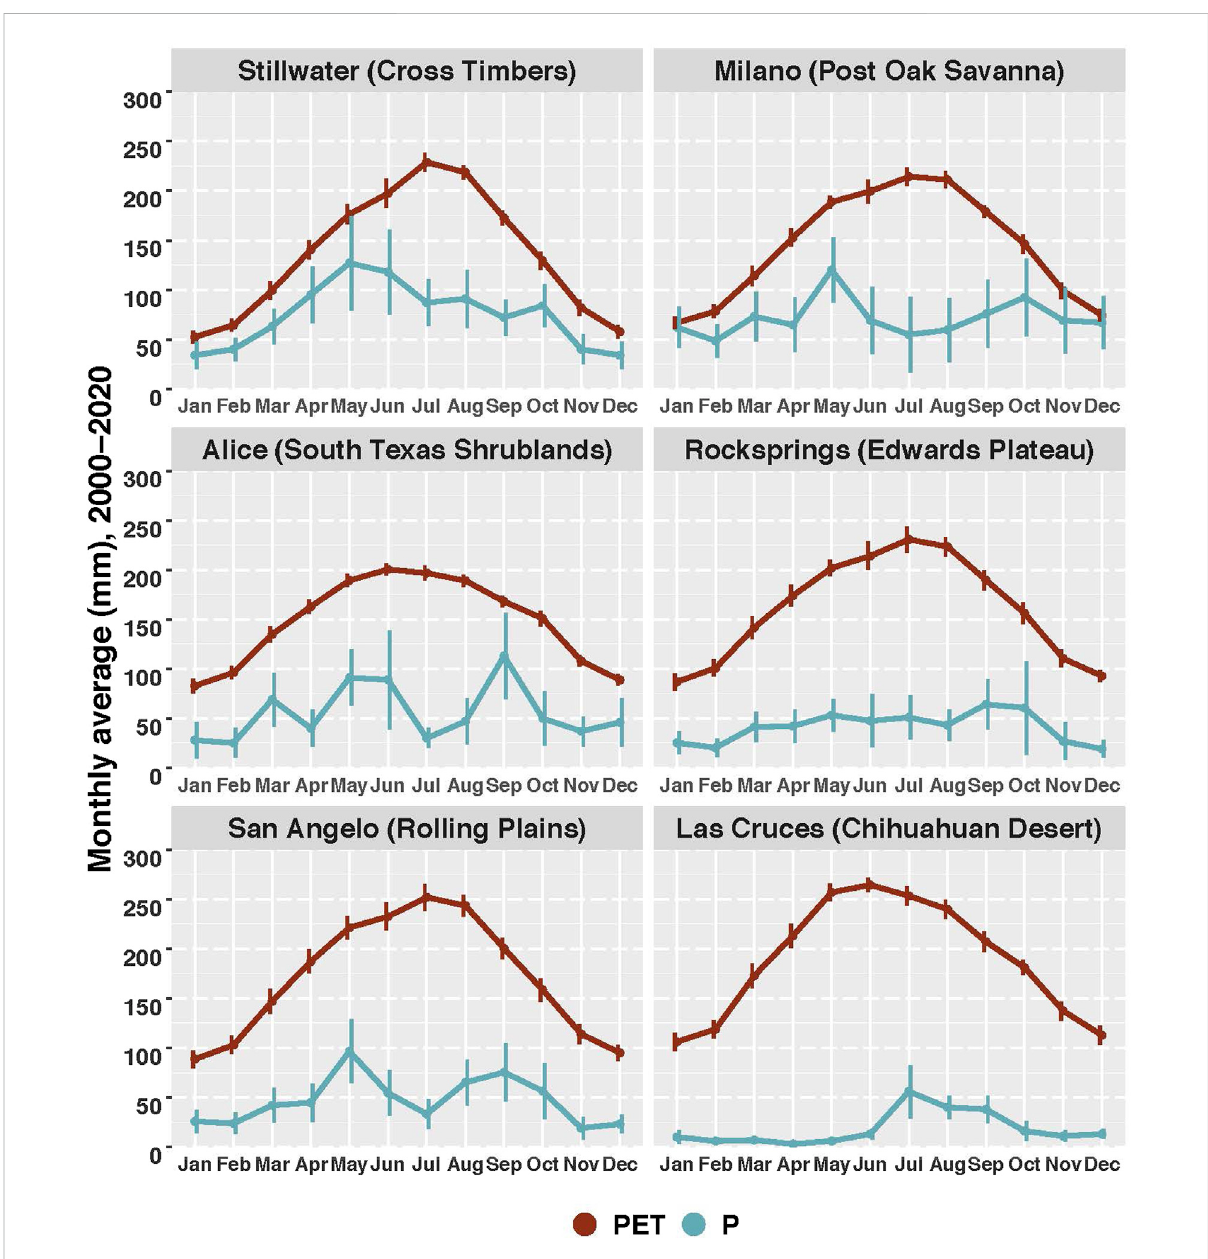
FIGURE 3 Mean values of potential evapotranspiraton (PET) and precipitation (P) for the period 2000 – 2020 in representative locations for each of the six case studies. PET was calculated using the MOD16 data set (Mu et al., 2011). Vertical bars represent 95% con fi dence